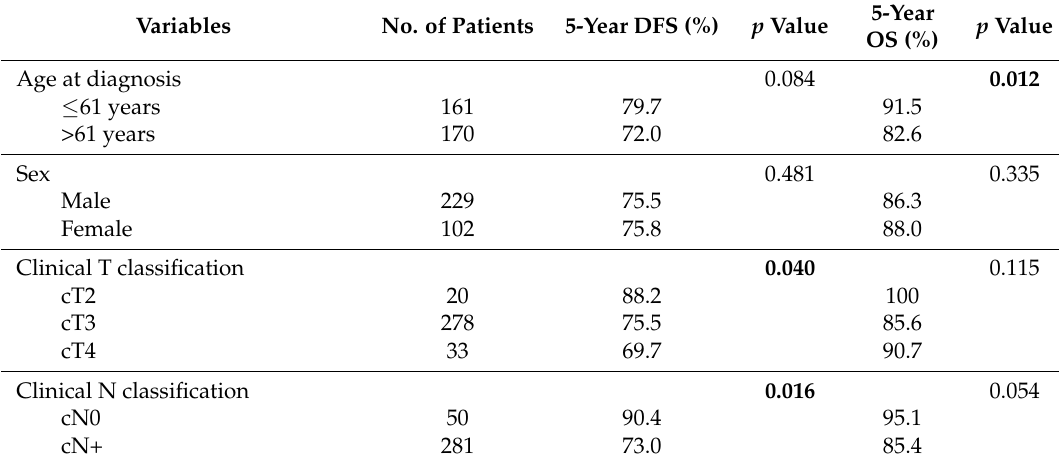
Table 2. Impact of different clinicopathologic factors on five-year